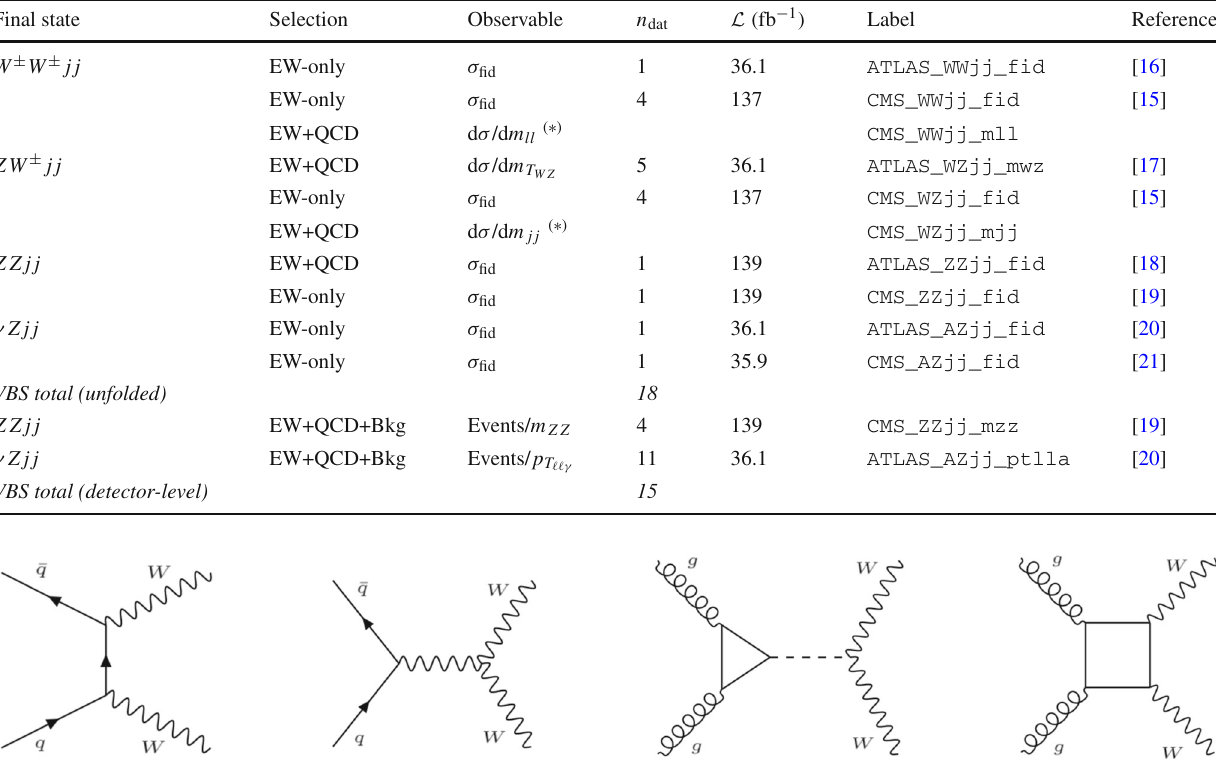
Table 5 Overview of the VBS measurements considered in this EFT analysis. We indicate the final state, the selection criteria, the experi- mental observable, the number of data points n dat and integrated lumi- nosity L . In the datasets labelled with ( ∗ ) , one bin from the differential